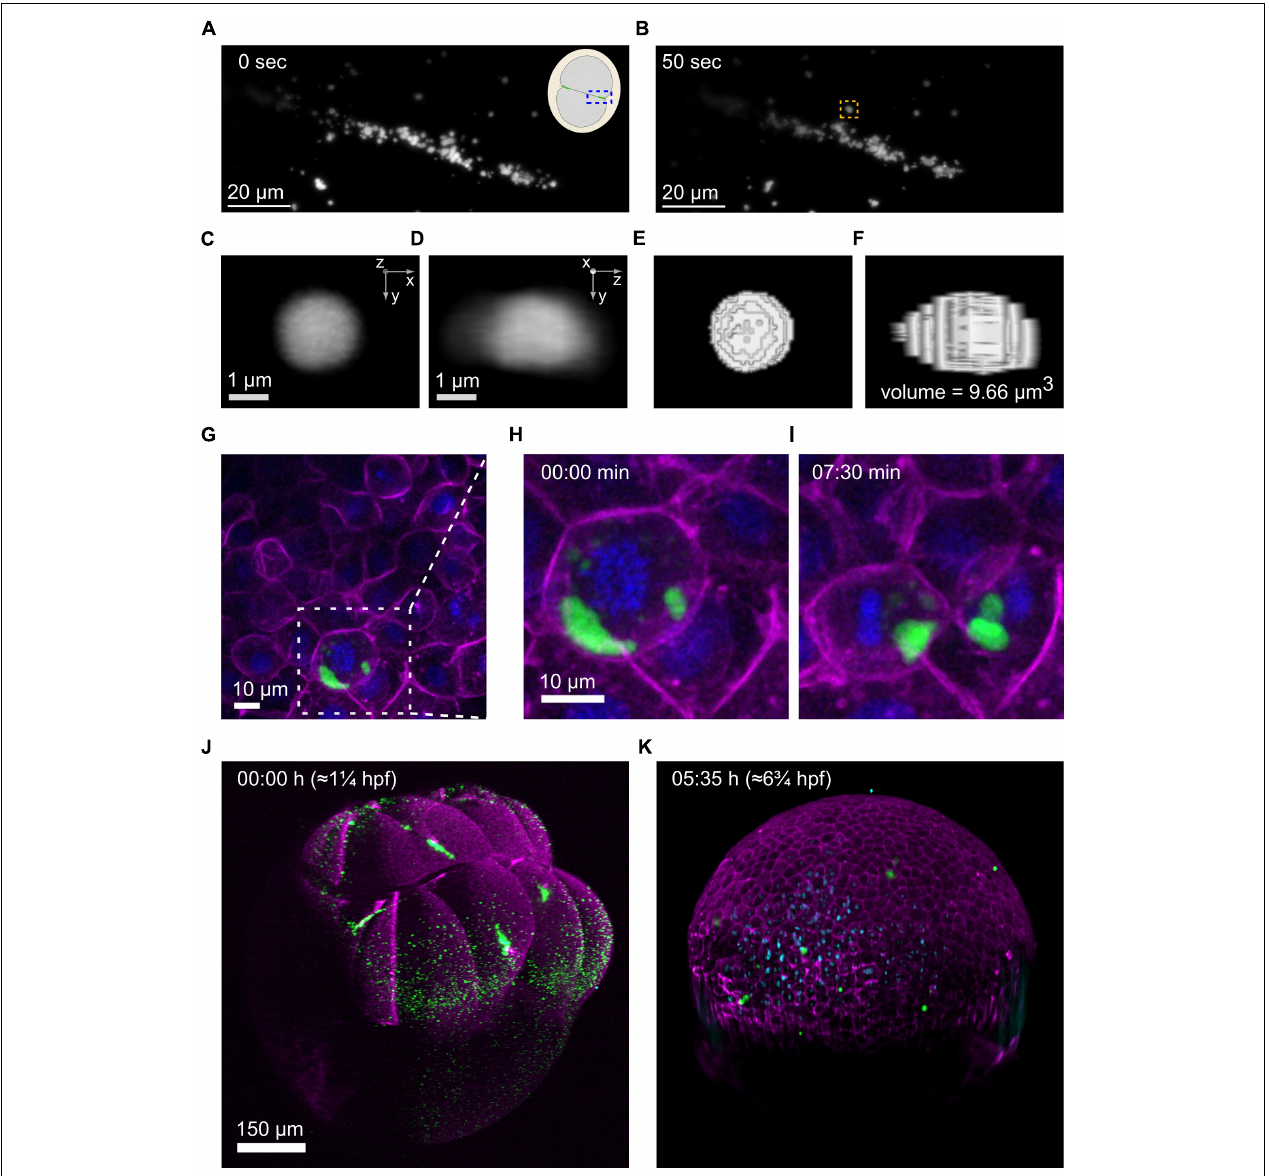
FIGURE 2 | Imaging of germplasm across scales (A–F) , Imaging of individual germ granules (RNP complexes). (A,B) , Stills from a 4d movie showing germplasm aggregation at the first cleavage furrow imaged on a 3i LLSM at two time points 50 seconds apart. The inset in the top right corner of the earlier time point (A) is a schematic illustrating the area that has been imaged in an animal pole view first cleavage embryo, highlighted by a blue box. One specific germ granule is framed in an orange box at the later time point (B) . (C–F) , This germ granule (at 31 s) was used for volume measurement by threshold segmentation in 3d. (C,D) , The granule is shown in two orthogonal views. (E,F) , The segmented granule in the same views, together with the measured volume. (G–I) , Imaging of individual PGCs. (G) Still from a 4d movie of germplasm segregation during cell division of a PGC at the oblong stage, imaged on a spinning disk confocal microscope. Germplasm is labeled by Buc-EGFP (green), membranes by Farnesyl-mCherry (magenta) and chromatin by H2Afv-tagBFP (blue). The middle and right panels show zoom-ins of the area highlighted by a dashed white box in (G) at the timepoints in (H) and (I) . (J,K) In toto imaging of germplasm in a zebrafish embryo over a 5.5 h duration on a 3i diSPIM microscope in SPIM mode. The first frame (8-cell, left) and the last frame (gastrula, right) are shown. Four large germplasm masses are observed at the 8-cell stage (J) and are partitioned into many PGCs in the gastrula (K) . Germplasm is labeled by Buc-EGFP (green), membranes and actin cortex by Farnesyl-mCherry and Utrn-mCherry (magenta), respectively, and chromatin by H2Afv-tagBFP (blue).